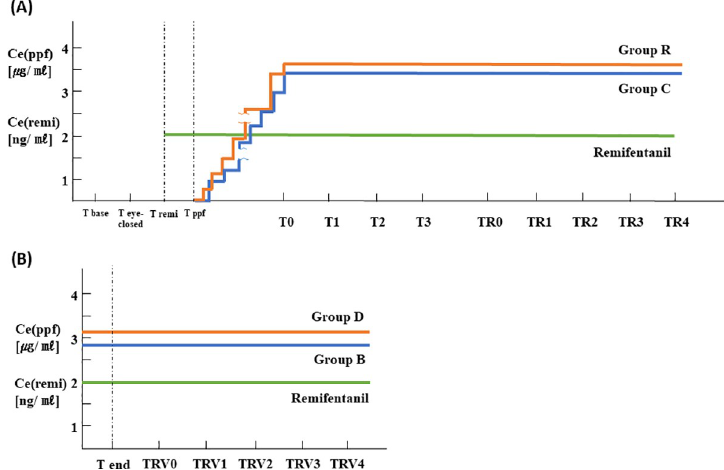
Fig 2. Time flow of the study at the induction and the end of surgery. (A) Ce (ppf): effect-site concentration of propofol, Ce (remi): effect-site concentration of remifentanil, Tbase: at baseline (in the eye-open state); Teye-closed: at 2 min after the patient’s eyes closed; Tremi: time when remifentanil TCI started; Tppf: time when propofol TCI started, T0: time when loss of consciousness (LOC) occurred; T1, T2 and T3: 1, 2 and 3 min after LOC, respectively, TR0, TR1, TR2, TR3 and TR4: immediately before, and at 1, 2, 3 and 4 min after injecting rocuronium (group R) or the same volume of normal saline (group C), respectively. (B) Ce (ppf): effect-site concentration of propofol, Ce (remi): effect site concentration of remifentanil, Tend: at the end of surgery, TRV0, TRV1, TRV2, TRV3 and TRV4: immediately before and at 1, 2, 3 and 4 min after injecting sugammadex (group B) or the same volume of normal saline (group D), respectively.